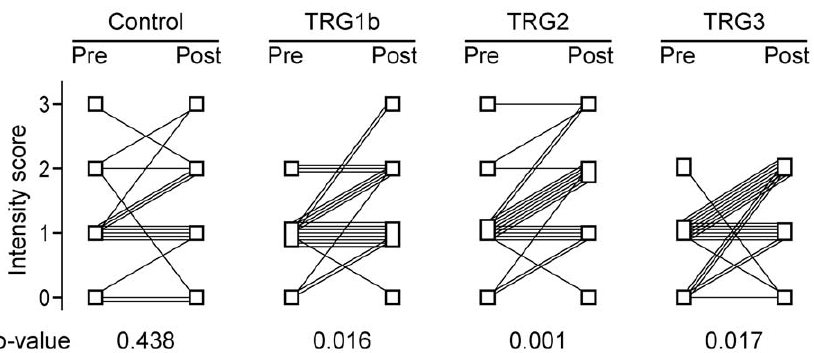
Figure 2. Alterations in the immunohistochemical staining for NOTCH2 between pre-therapeutic biopsies and their corresponding post-therapeutic tumours. Alterations of cytoplasmic staining intensities are shown. Each line indicates the alteration of the immunohisto- chemical staining score between the pre-therapeutic biopsy (Pre) and the corresponding post-therapeutic tumour specimen (Post) for each case. P- values were determined by the Wilcoxon signed rank test (exact).